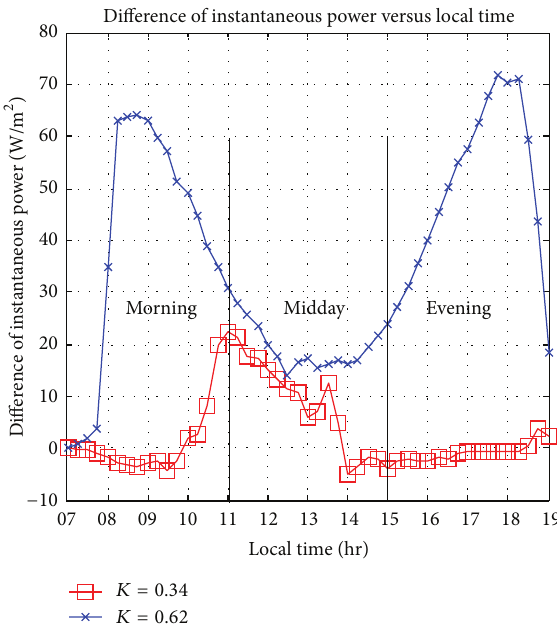
Figure 8: Difference of instantaneous power of DAST and SSS along the sunny day and cloudy day.